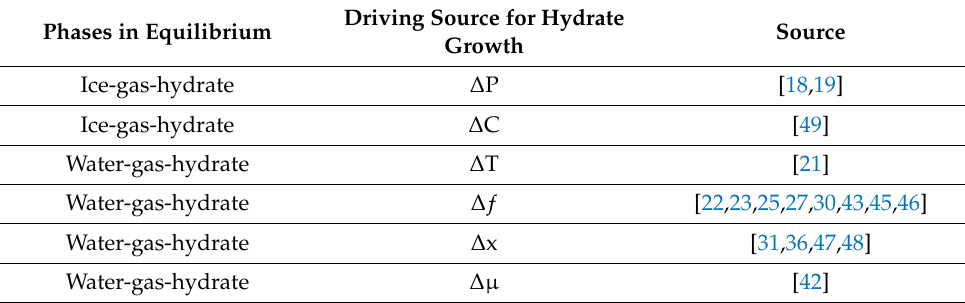
Table 4. Summary of proposed driving forces for gas hydrate